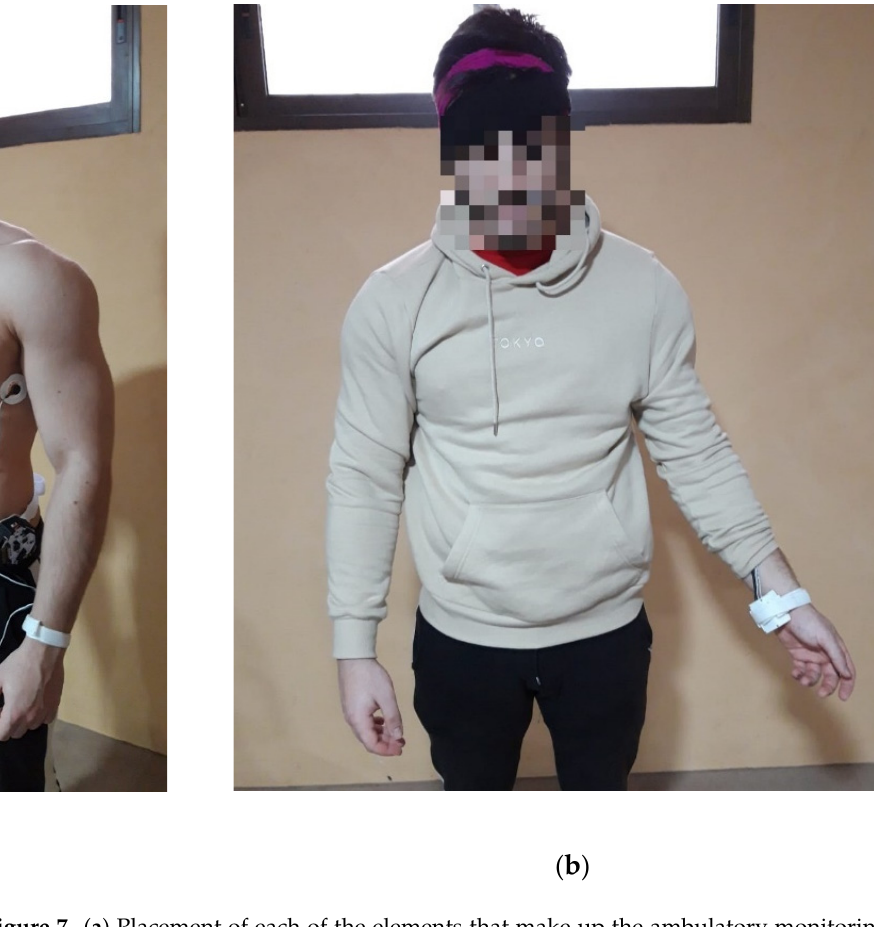
Figure 7. ( a ) Placement of each of the elements that make up the ambulatory monitoring system on the user; ( b ) Final arrangement of the ambulatory monitoring system on the user with clothing. It can be seen that the design is unobtrusive and produces practically no disturbance to the user ʹ s daily